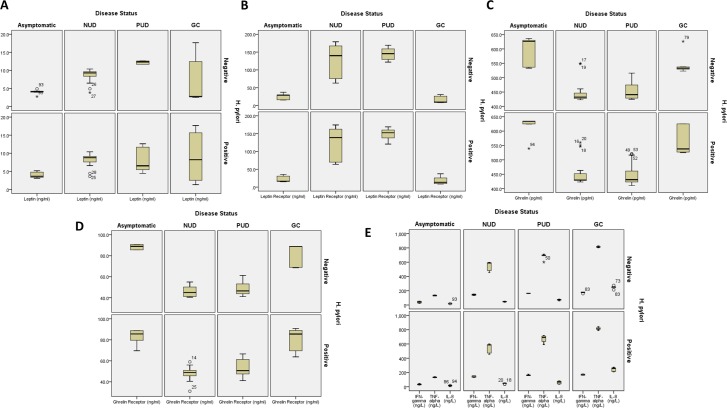
Whiskers plot analysis of distribution of plasma immunoreactive gut hormones (A) Leptin (B) Leptin receptor (C) Ghrelin (D) Ghrelin receptor (E) pro-inflammatory cytokine concentrations (TNF-α, IFN-γ, IL-8) in gastroduodenal diseases and gastric cancer (GC).Plasma leptin, leptin receptor, ghrelin, ghrelin receptor, TNF-α, IFN-γ and IL-8 concentrations measured using commercial double-antibody sandwich ELISA. Data were from three independent experiments. Level of significance set at p<0.05. (Note: IL, interleukin; IFN-γ, interferon gamma; TNF-α, tumor necrosis factor alpha)